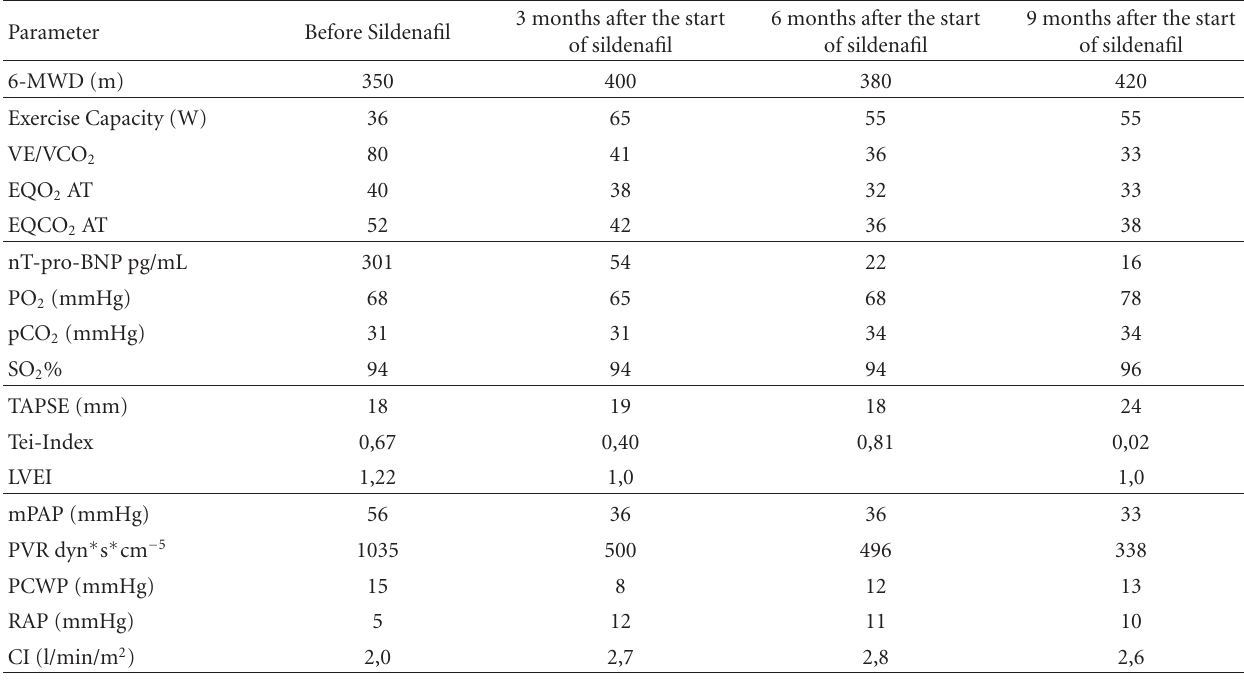
Table 1: Pulmonary Langerhans cell granulomatosis: functional parameters before and under sildenafil. Parameter Before